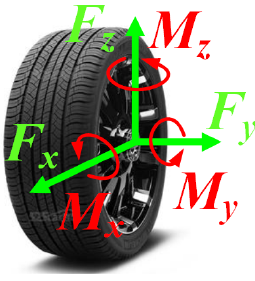
Figure 1. Definition of wheel forces.